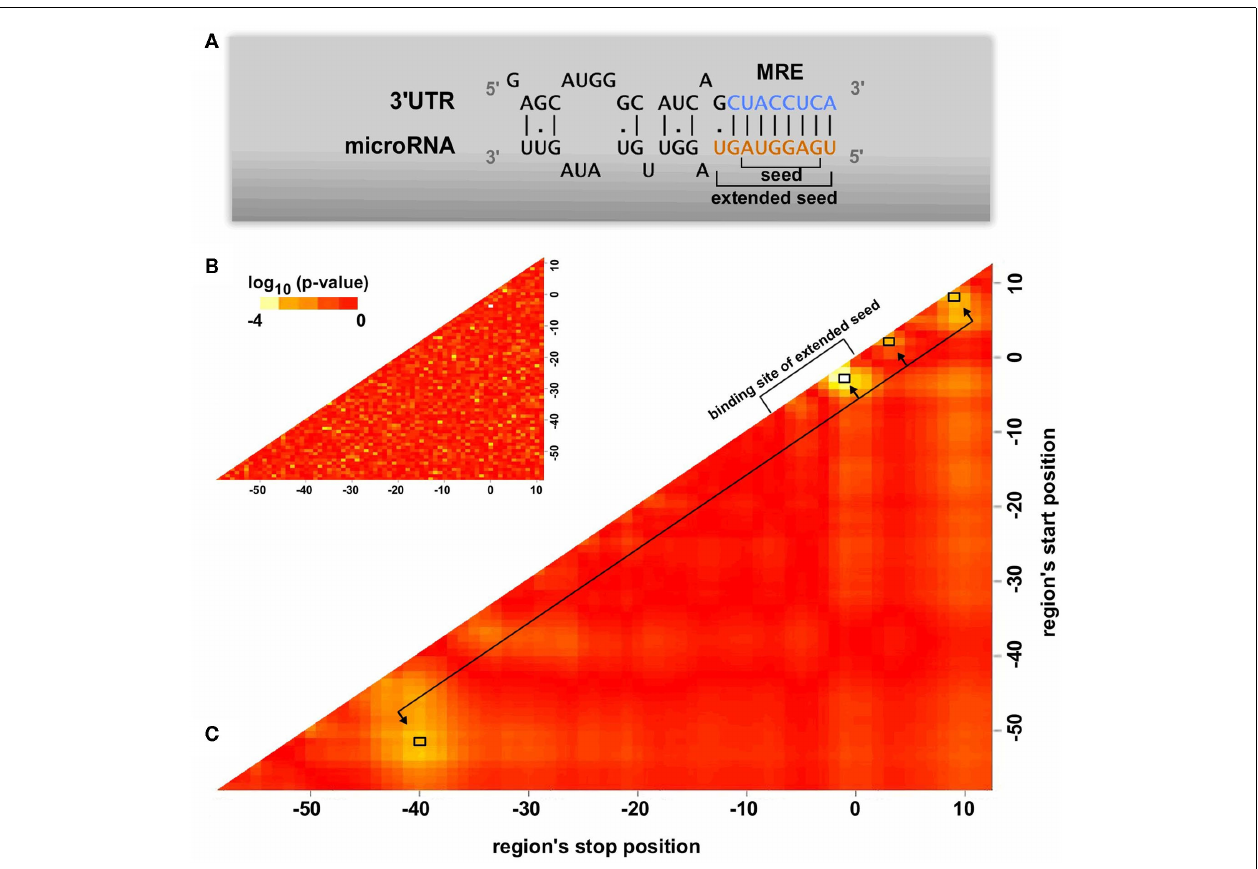
on the y axis. Heatmap B has been created by randomly categorizing the genes as targeted or not targeted, serving as an estimate of the randomness in the analysis. In both heatmaps the seed of the miRNA corresponds to region 0–8. Heatmap C indicates four significant regions ( − 51 to − 40, − 3 to − 1, 2 to 3, 8 to 9) which have significant accessibility differences between putative MREs of targeted and non-targeted genes. The average accessibility of these regions has been used as an MRE property in the artificial neural network